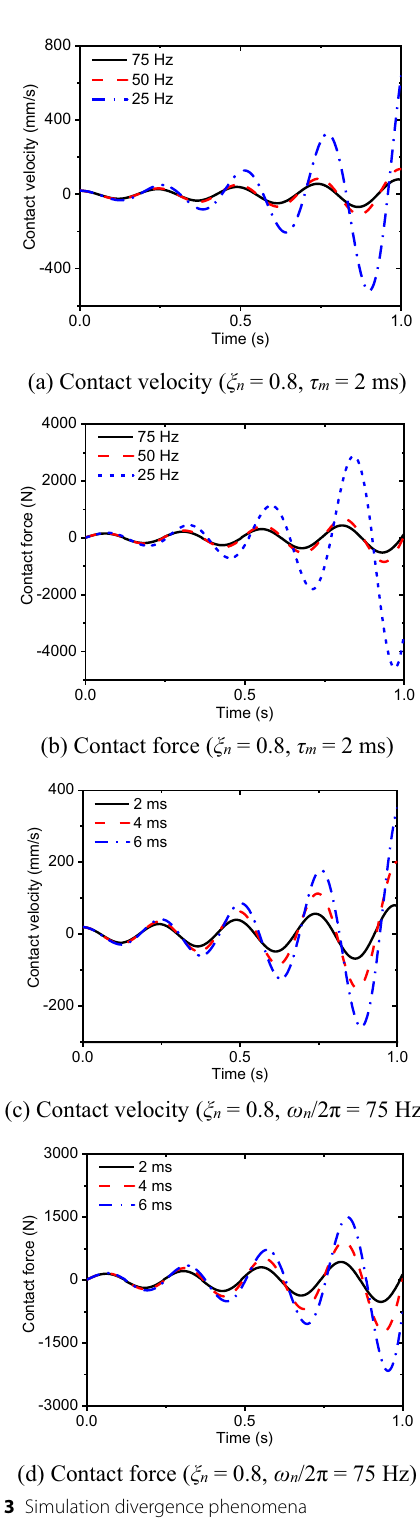
Figure 3 Simulation divergence